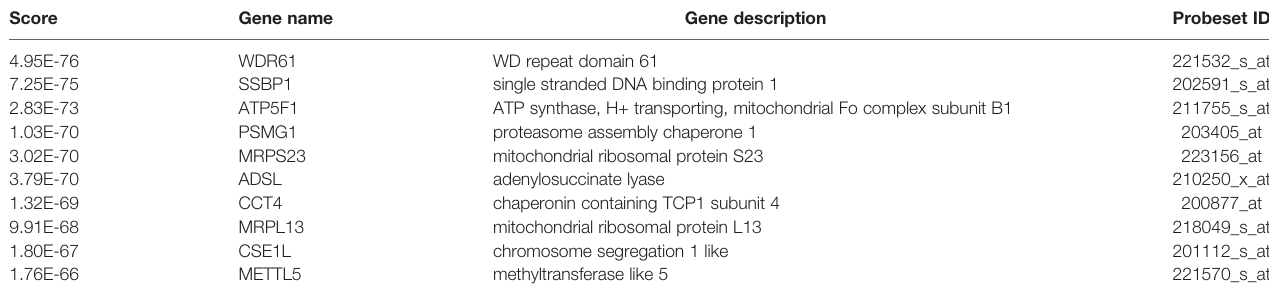
TABLE 3 | Co-expression genes of NUP37(Top